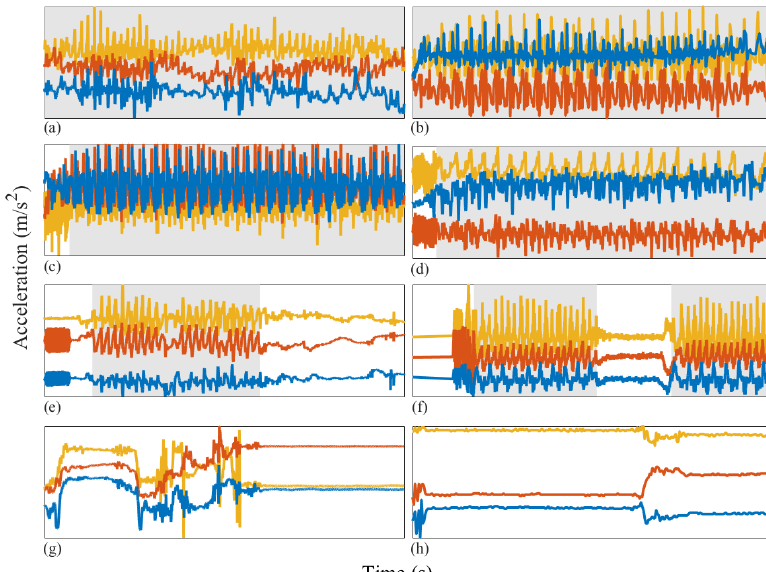
Figure 2. Illustrative examples of walking clinimetric test sensor data recorded using a smartphone accelerometer from healthy individuals and those with PD. Left column: walking tests from PD patients, right column: healthy individuals. The horizontal axis represents time in seconds (approximately 30 s) and the vertical axis (orange, red and blue) three-axis acceleration (m/s 2 ). Grey shaded areas: data segments in which the user is hand-labeled as adhering to the test protocol. ( a ) PD patient walking throughout the test; ( b ) healthy individual walking throughout the test; ( c ) smartphone buzzer inn